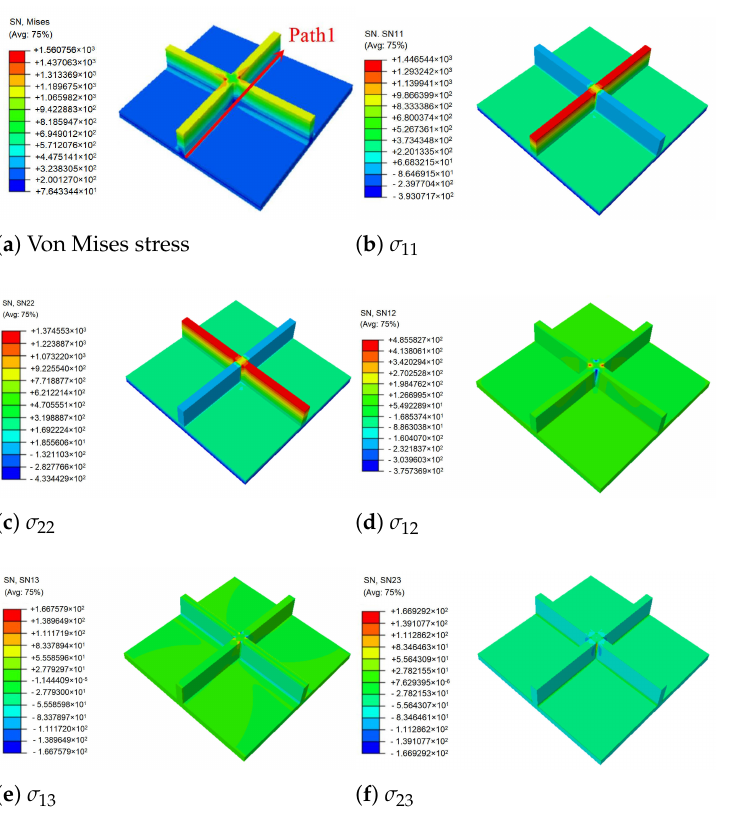
Figure 9. Local stress fields within the unit cell at the geometric center of the plate (unit: MPa).